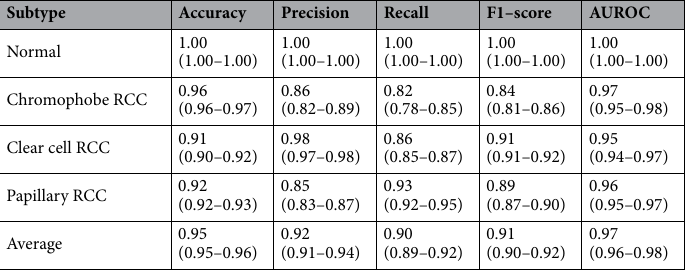
Table 1 summarizes the per-class and average evaluation of our model on the first test set of surgical resection whole-slide images from DHMC. Our model achieved a mean accuracy of 0.97, a mean precision of 0.94, a mean recall of 0.92, a mean F1-score of 0.92, and a mean AUC of 0.98 (95% CI: 0.97–1.00) on this internal test set of resection slides. Table 2 shows the performance summary of our model on whole-slide images from the kidney renal carcinoma collection of the TCGA databases. We achieved high performance on these external resection whole-slide images with a mean accuracy of 0.95, a mean precision of 0.92, a mean recall of 0.90, a mean F1-score of 0.91, and a mean AUC of 0.97 (95% CI: 0.96–0.98). Table 3 presents the per-class and mean performance metrics of our model on 79 biopsy whole-slide images from DHMC. Our model shows great generalizability on